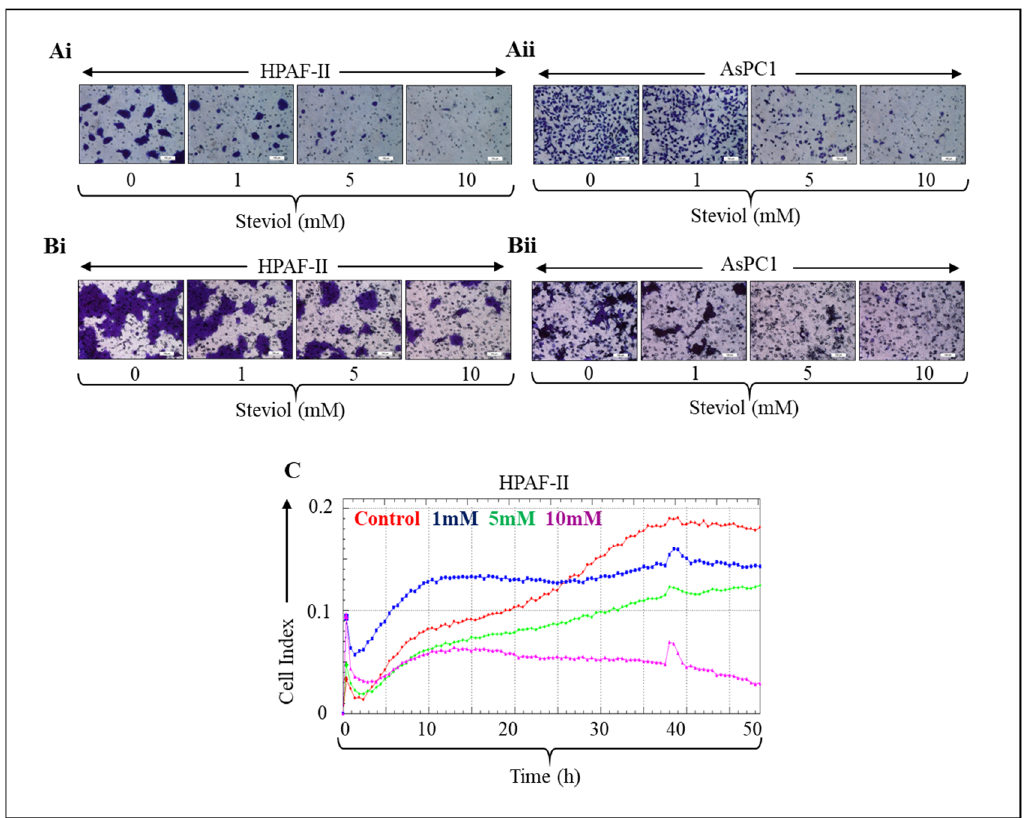
Figure 2. Steviol inhibits cell invasion and cell migration in pancreatic cancer cells. ( A ) Matrigel invasion assay was performed on pancreatic cancer cells HPAF-II ( Ai ) and AsPC1 ( Aii ); the cells were treated with steviol at indicated concentrations for 24 h. Thereafter, the cells were washed with PBS, fixed with methanol and stained using crystal violet. Upon drying, images were taken. (Magnification, 200×); ( B ) Boyden chamber migration assay was performed on pancreatic cancer cell cells HPAF-II ( Bi ) and AsPC1 ( Bii ); the cells were treated with 0, 1, 5, and 10 mM concentrations for 18 h. After that, cells were fixed with 4% paraformaldehyde, stained with crystal violet and left for drying. Furthermore, the images were captured (Magnification, 200×). ( C ) The pancreatic cancer cells were subjected to the xCELLigence instrument; cell migration assay (with 0, 1, 5, and 10 mM of steviol) was also carried out on the CIM-plate.